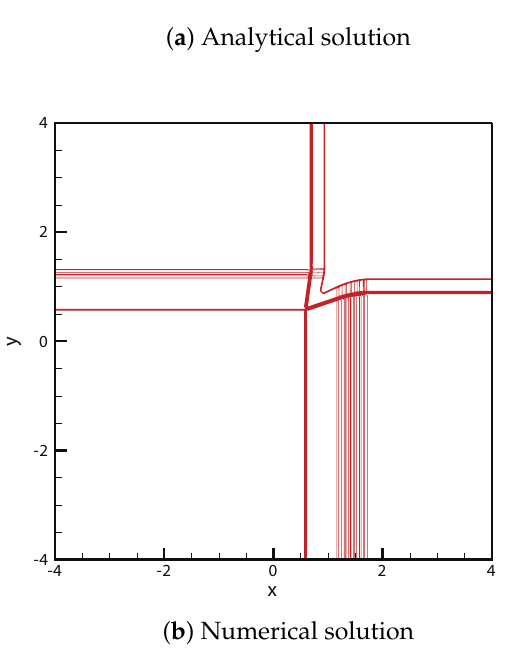
Figure 10. Case 8. SJ + RJ + JR + JS. Case 9. JR + JS + RJ + SJ ( u 2 < u 1 < u 3 < u 4 < 0